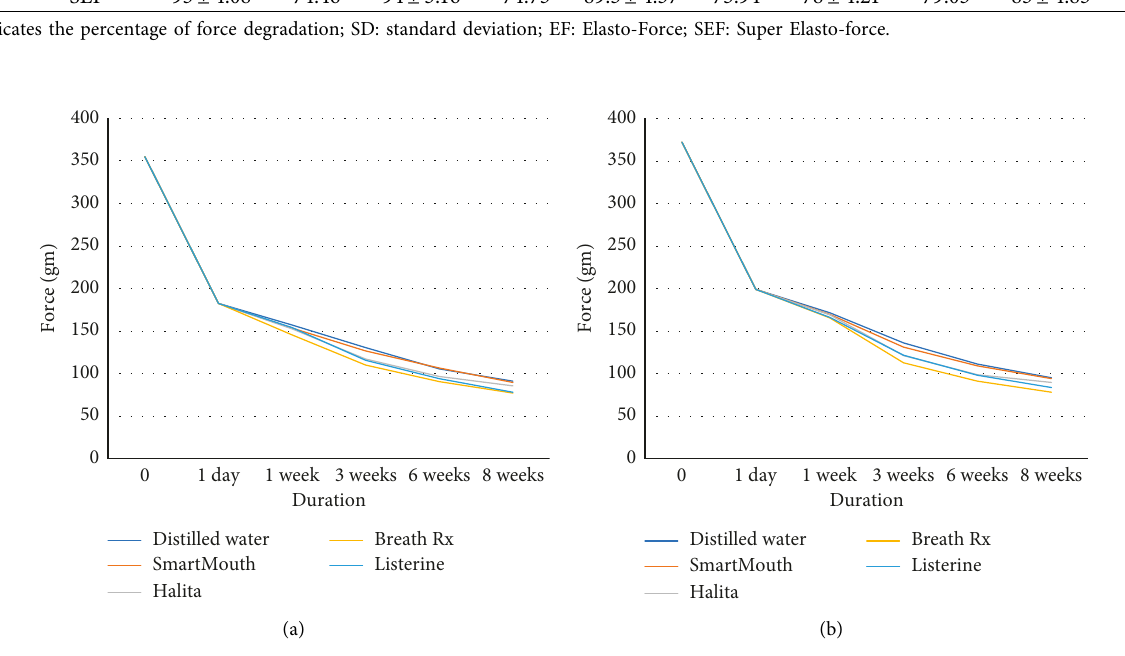
Figure 1: Mean values of the force delivered from Elasto-Force (a) and Super Elasto-Force (b) elastomeric chains treated with different chemical solutions. Table 3: Effect of time intervals on the force level of two types of elastomeric